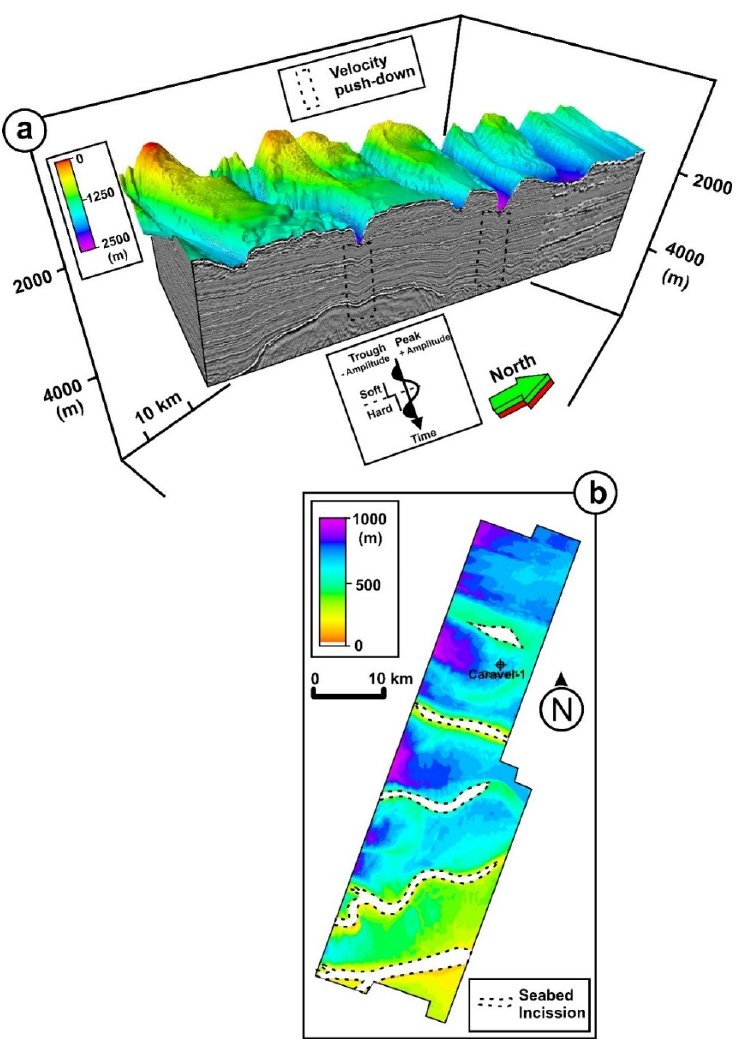
Figure 11. ( a ) Three-dimensional view of Seabed horizon and seismic amplitude, and ( b ) Thickness map between seabed and top Neogene (study interval). See Figure 1a for coordinate location.